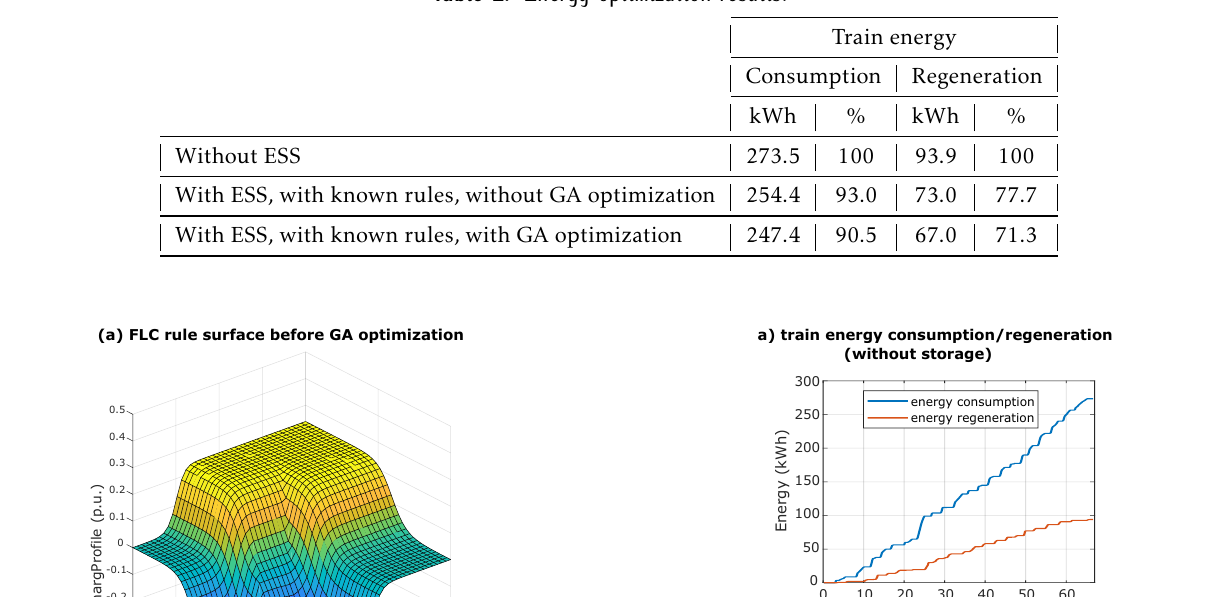
Table 2. Energy optimization results.